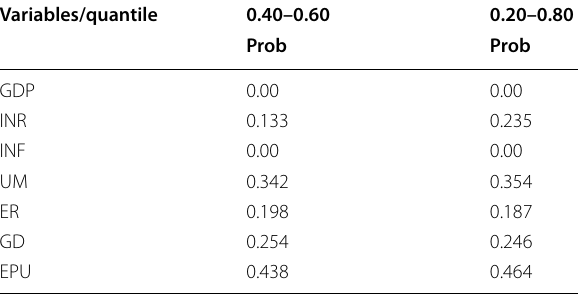
Source: Research finding